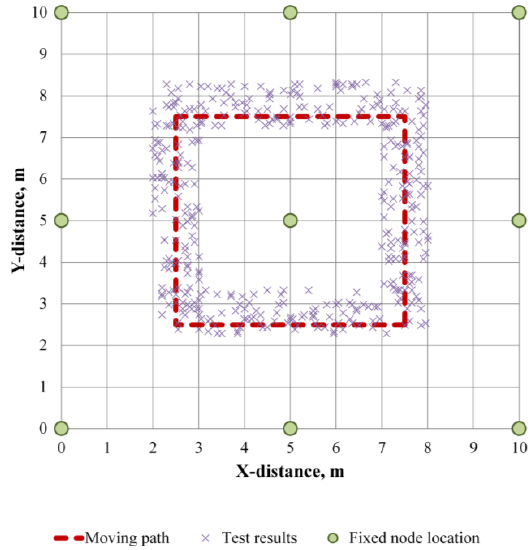
Figure 9. Tracking result of moving tag in underground construction site.